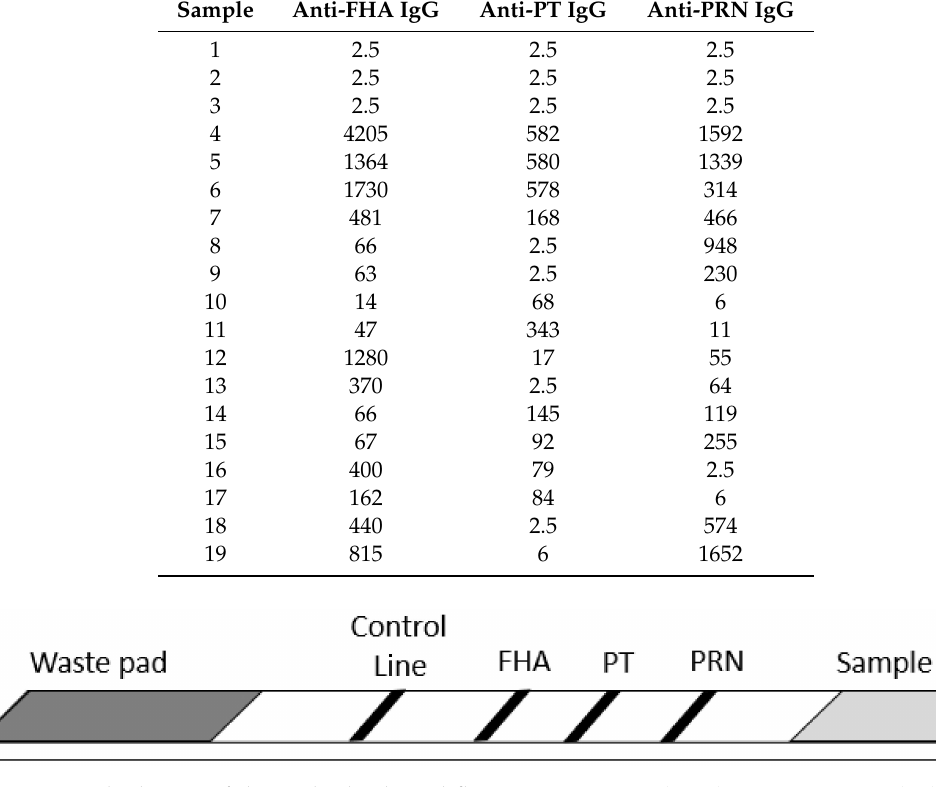
Figure 1. The layout of the multiplex lateral flow test. Pertactin (PRN), pertussis toxin (PT) and filamentous hemagglutinin (FHA) antigen test lines were absorbed on the nitrocellulose membrane, in respective